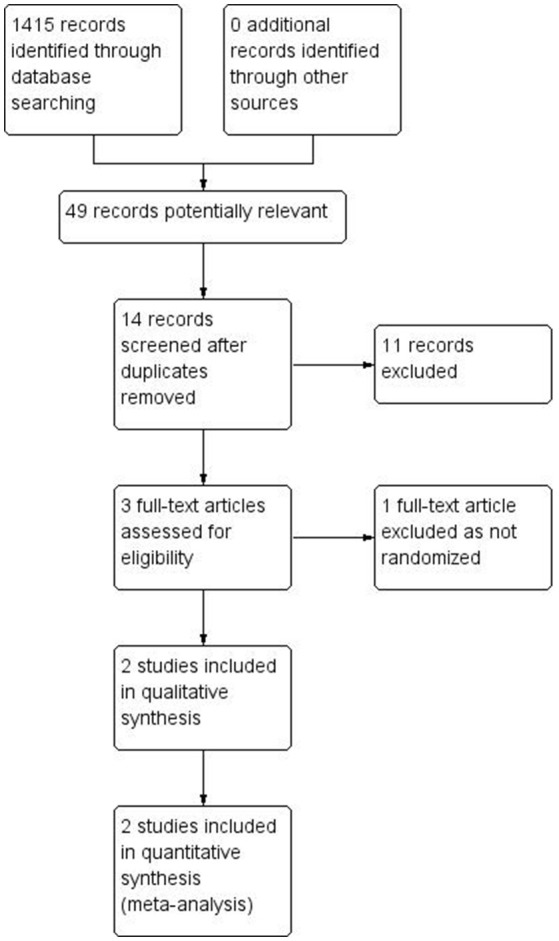
Study flow diagram.